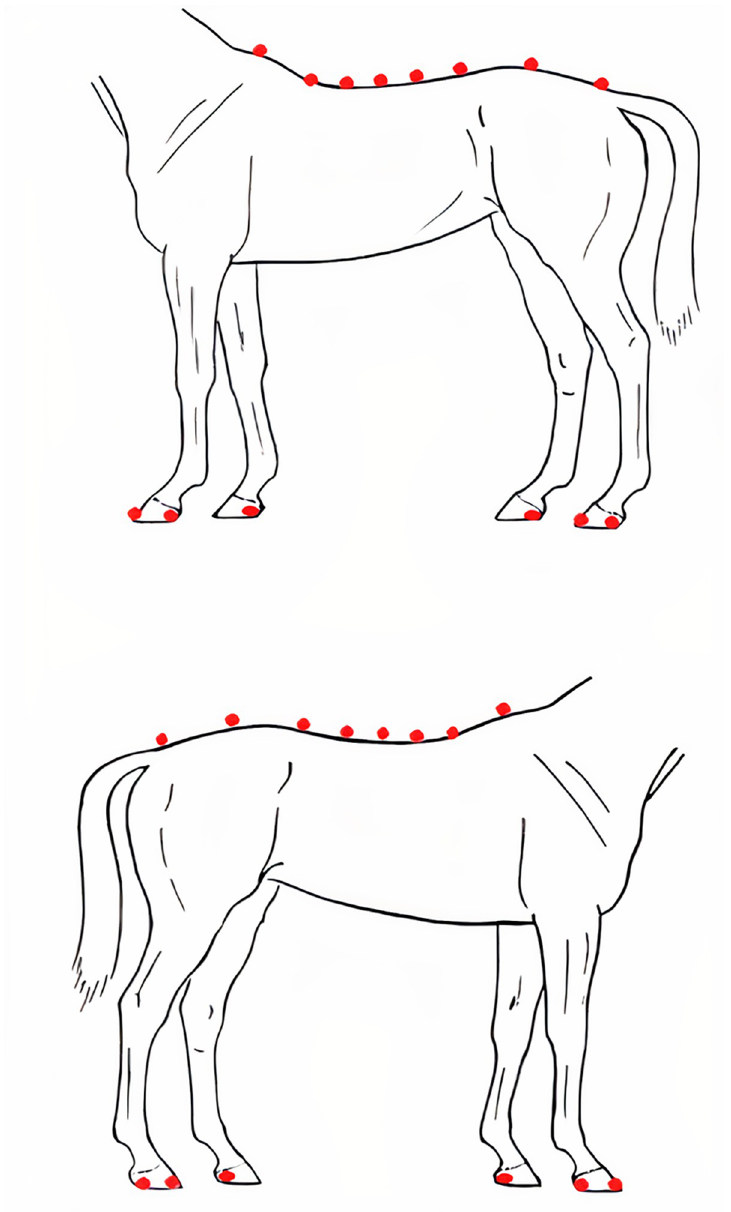
Fig 2. Marker’s position the fixed on the animal’s skin or